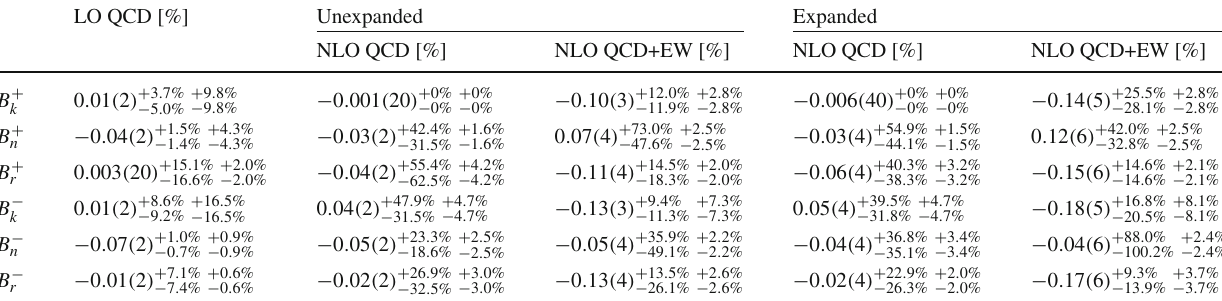
Table 1 The B coefficients as defined in Eq. (16) at various orders both expanded and unexpanded LO QCD [%] Unexpanded Expanded